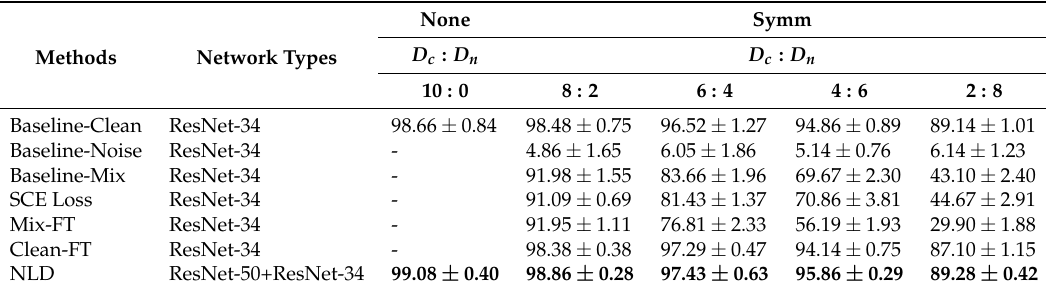
Table 4. Classification accuracy (%) on the UC Merced Land-use test set for different methods trained with the original noise-free dataset and symmetric label noise. We report the mean and standard error across 5 runs.